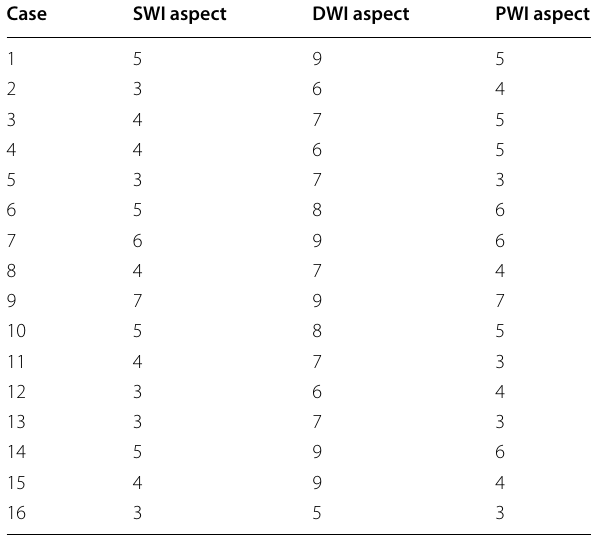
Table 2 Aspect score for patients